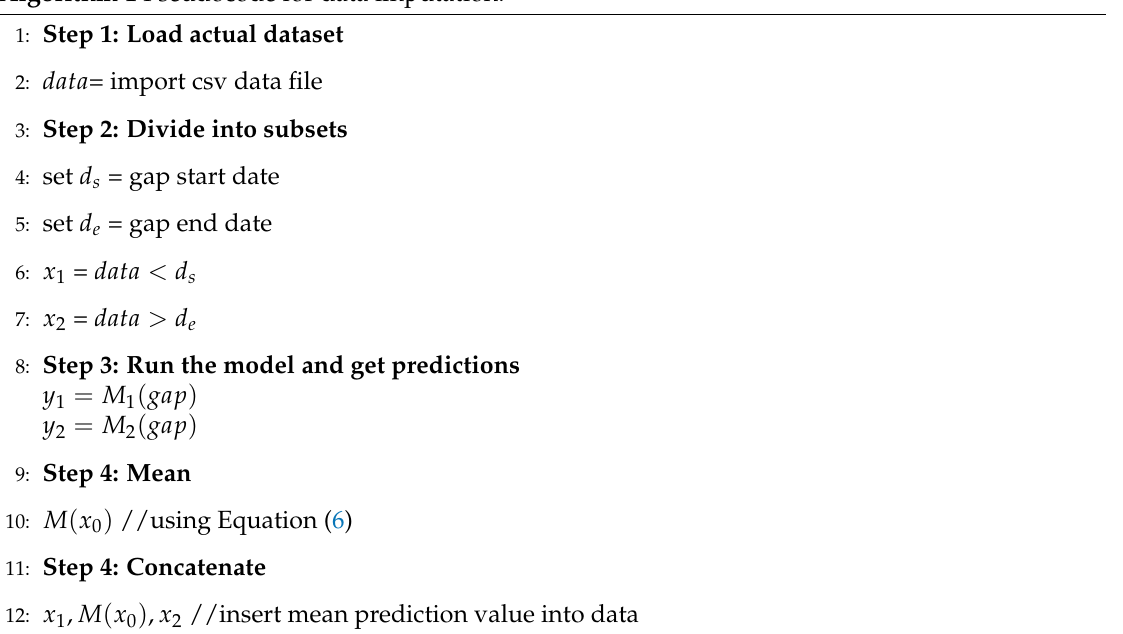
Algorithm 1 Pseudocode for data imputation.